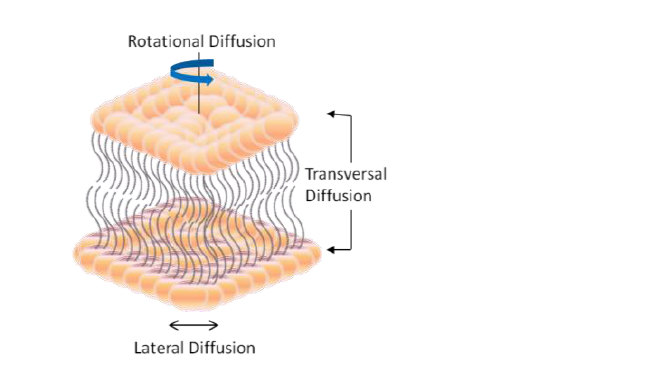
Figure 3. Diffusion mechanism inside the lipid bilayer membrane